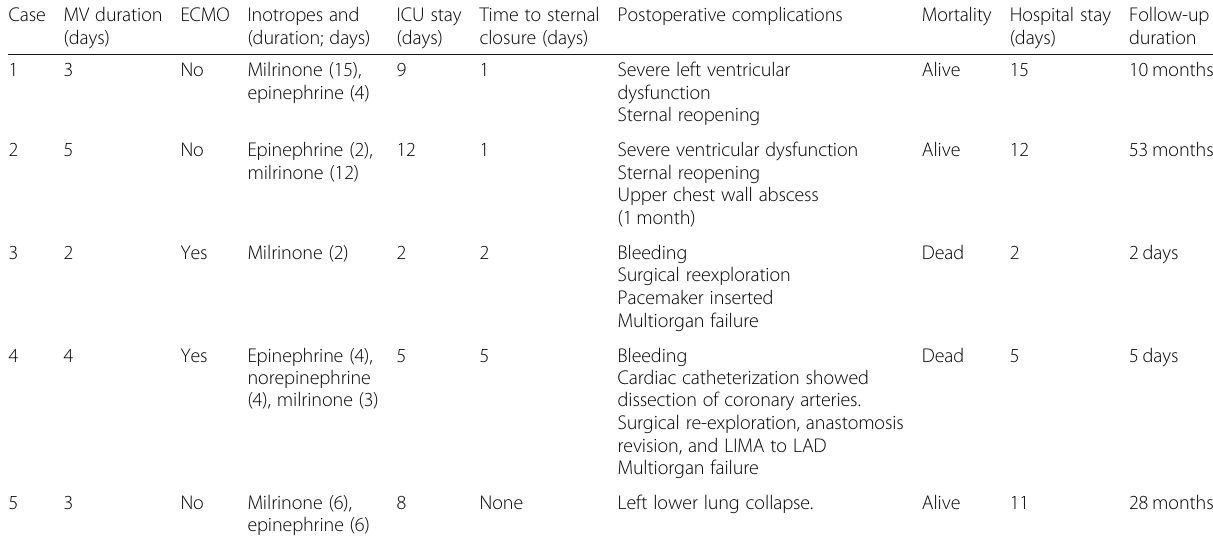
Table 3 Postoperative outcomes after ALCAPA repair Case MV duration